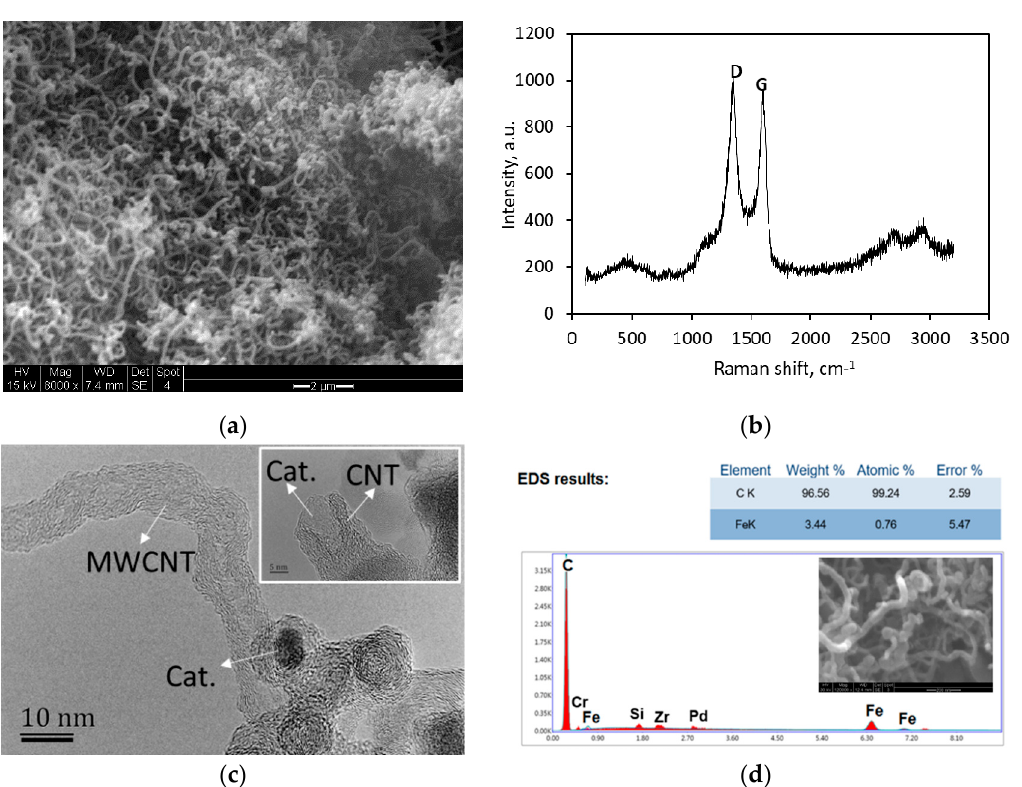
Figure 2. Characterizations for the carbon/catalyst materials formed in the HTP WGS MR: ( a ) SEM image, ( b ) Raman shift, ( c ) TEM image, and ( d ) SEM–EDS results.